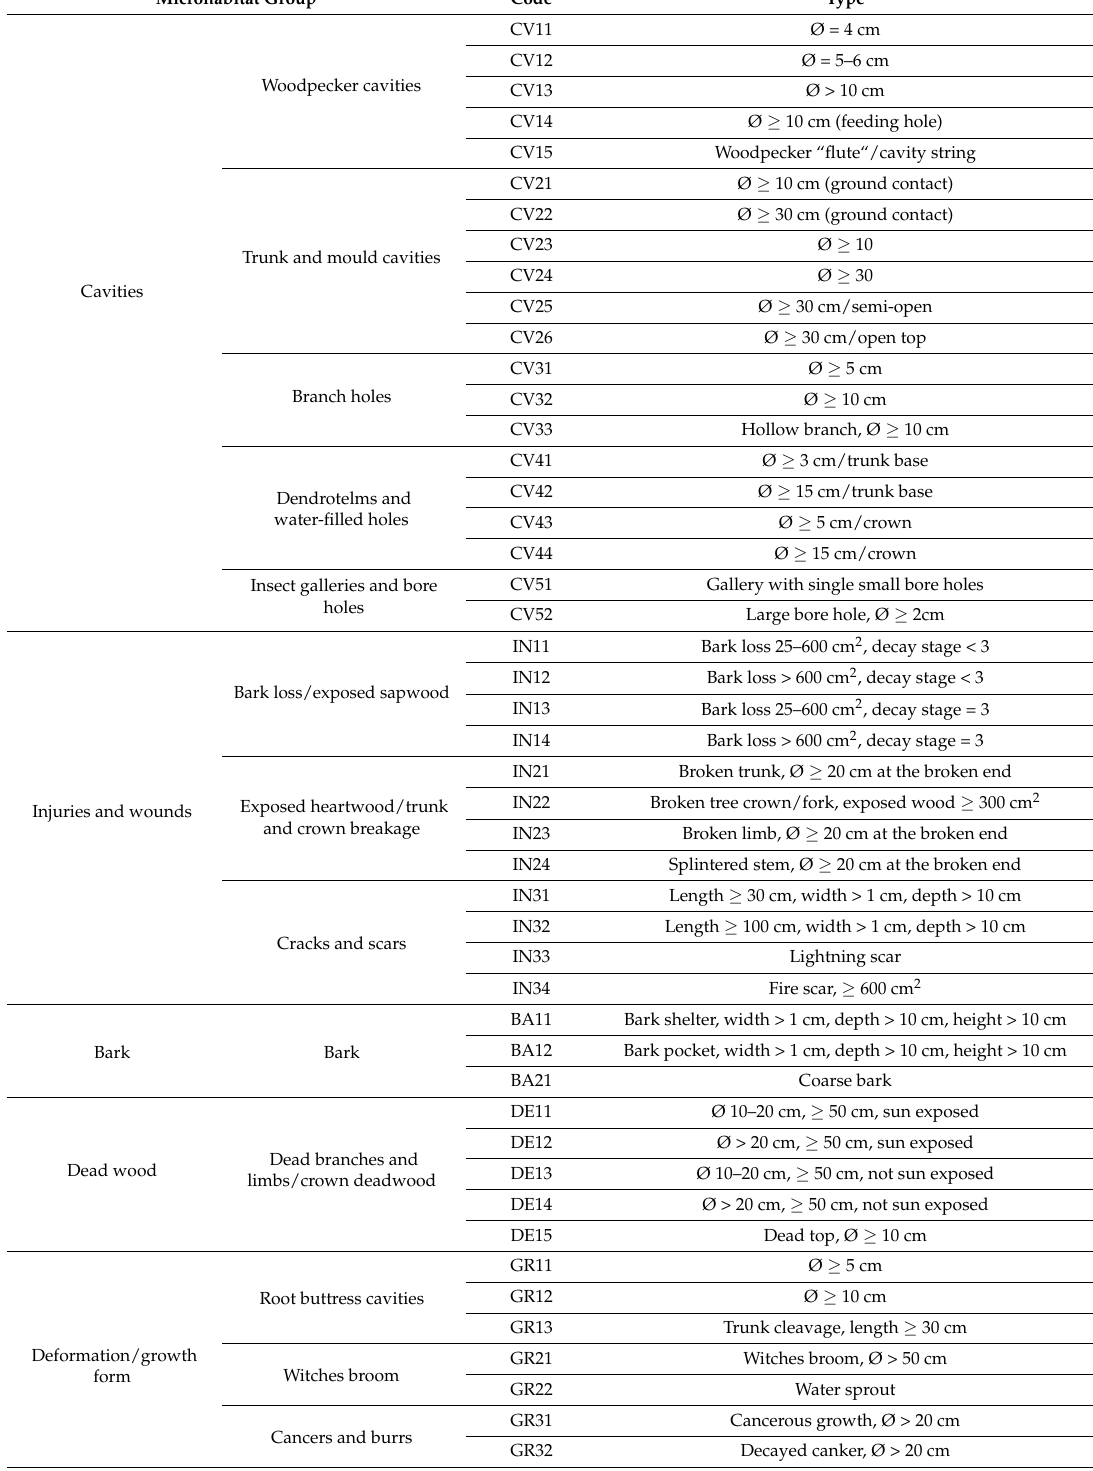
Table A1. Catalogue of the inventoried microhabitats with the code, description, and criteria for each structure (after